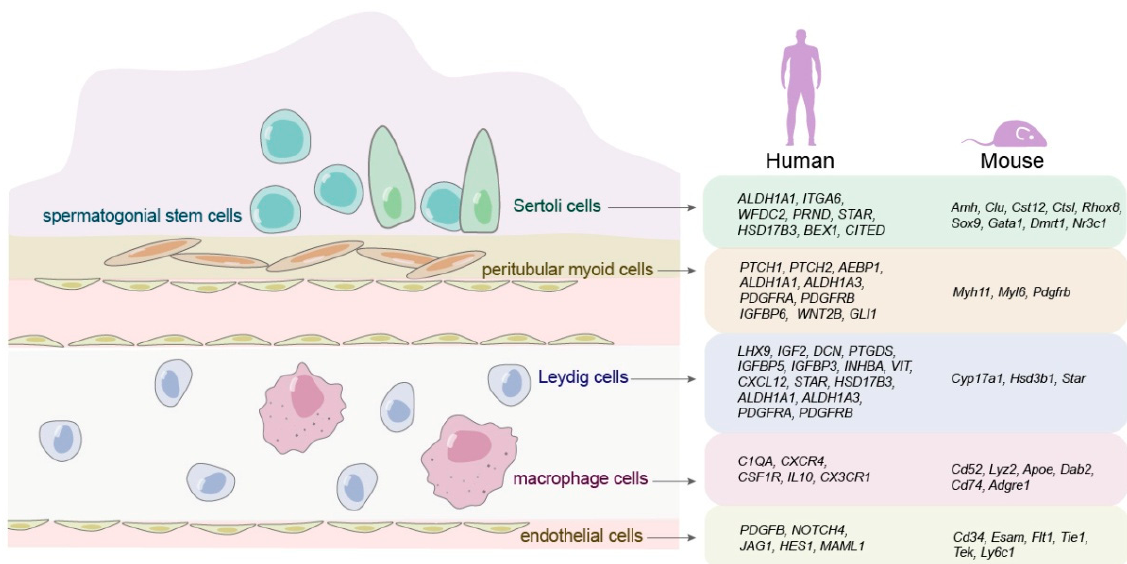
Figure 2. Expression of new genes in somatic cells of testis by single-cell RNA sequencing. Left panel: schematic illustration of major somatic cell types in the testis; right panel: new genes specifically expressed in specific types of somatic cells in human and rodent testis.